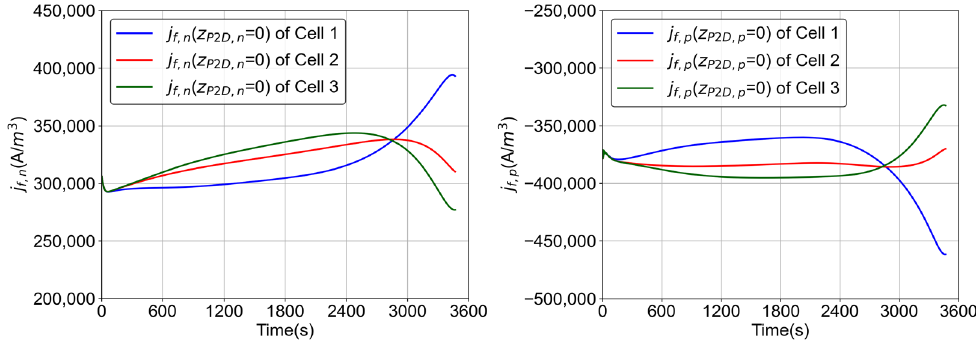
Figure 17. j f of PCBS_1 under the inhomogeneous cooling case 13.